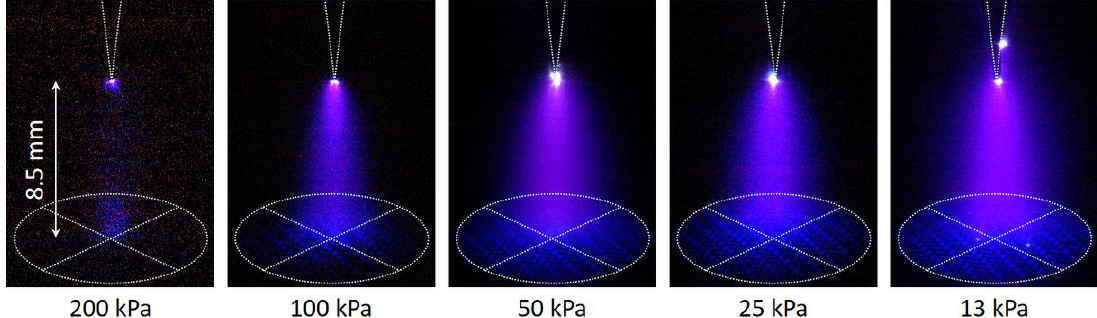
Figure 3. Images of the discharge plasma emission in a point-to-plane gap filled with air at various pressures when applying voltage pulses with an amplitude of 27 kV.